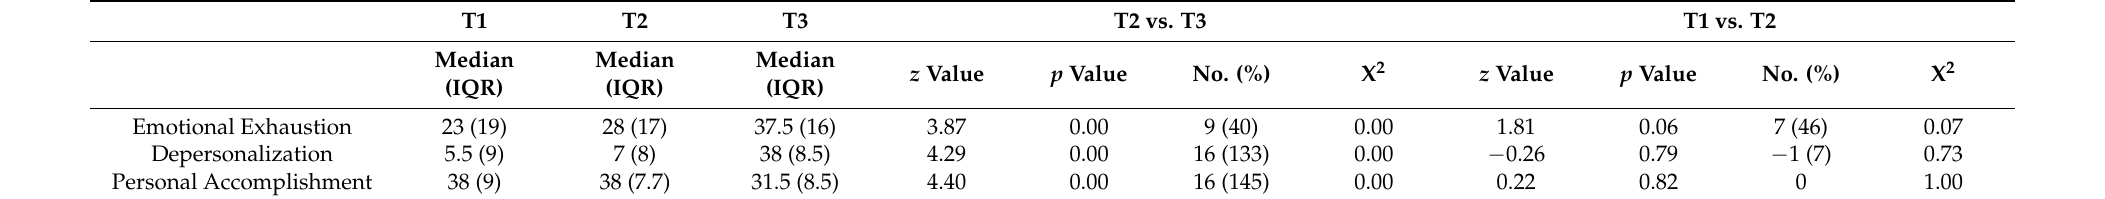
Table 3. Stability MBI scores